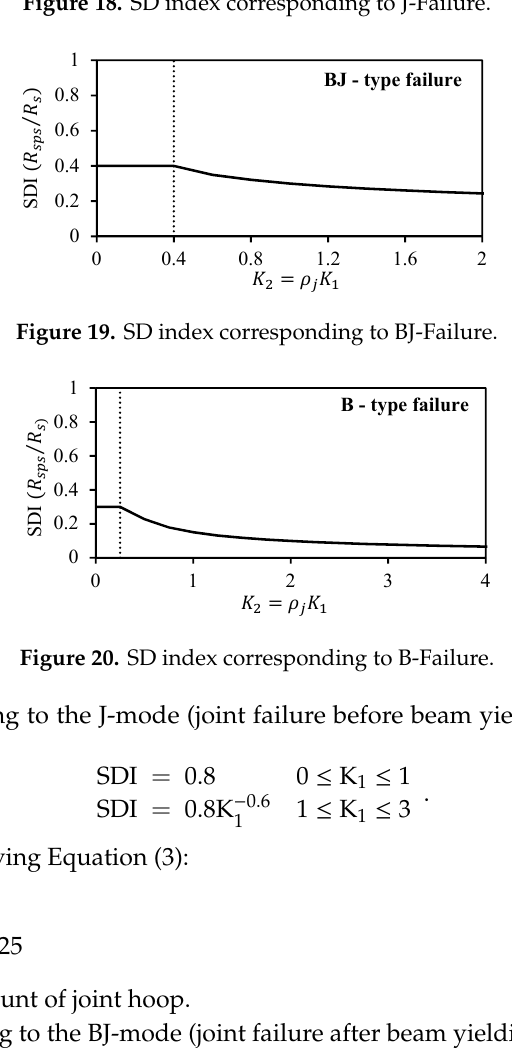
Figure 20. SD index corresponding to B-Failure